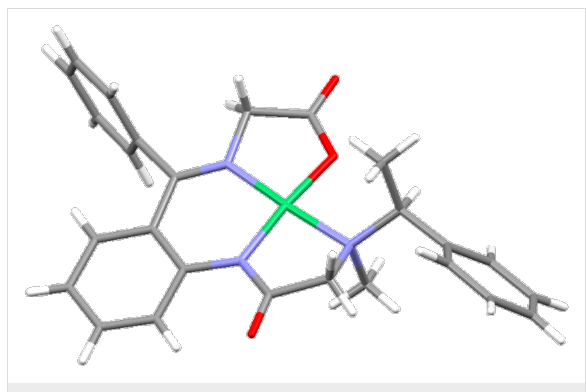
Figure 3: Crystallographic structure of ( S C R N )- 5b showing an expo- sure of the methyl moiety of α -phenylethylamine to the Ni(II).